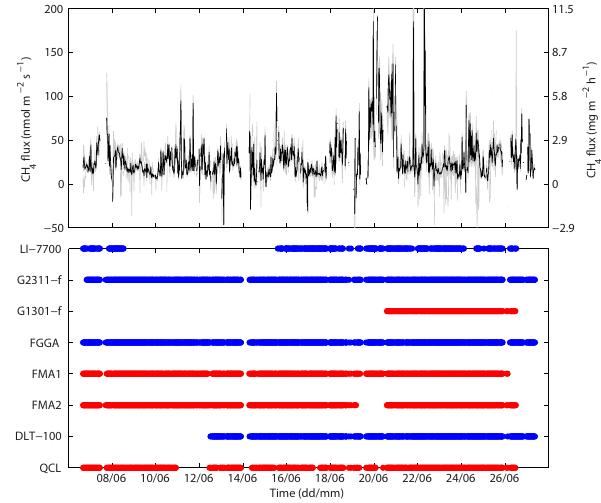
Figure 2. Upper plot shows CH 4 flux time series (grey lines: in- dividual CH 4 flux time series; black line: median CH 4 flux time series) and the bottom plot shows periods when gas analysers were working. Red colour corresponds to fluxes measured with METEK2 and blue to fluxes measured with METEK1.